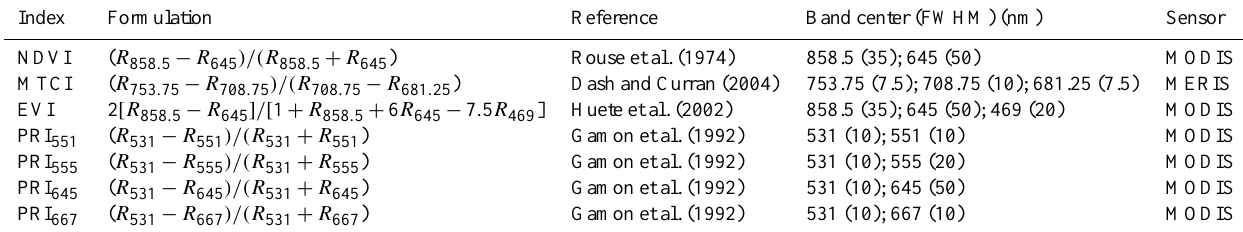
Table 1. Spectral vegetation indexes investigated in this study: normalized difference vegetation index, NDVI; enhanced vegetation index, EVI; MERIS terrestrial chlorophyll index, MTCI; photochemical reflectance index, PRI. R is the reflectance at the specified wavelength (nm). FWHM is full width at half maximum in